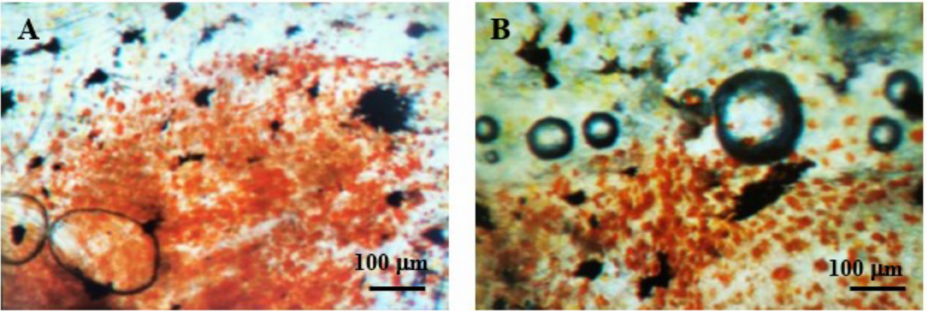
Figure 1. Skin tissue from red spot before ( A ) and after the trypsin digestion for 40 min ( B ). Trypsin digestion causes chromatophore shrinkage, but the cells still form cell clumps. The photo was taken under a binocular loupe.